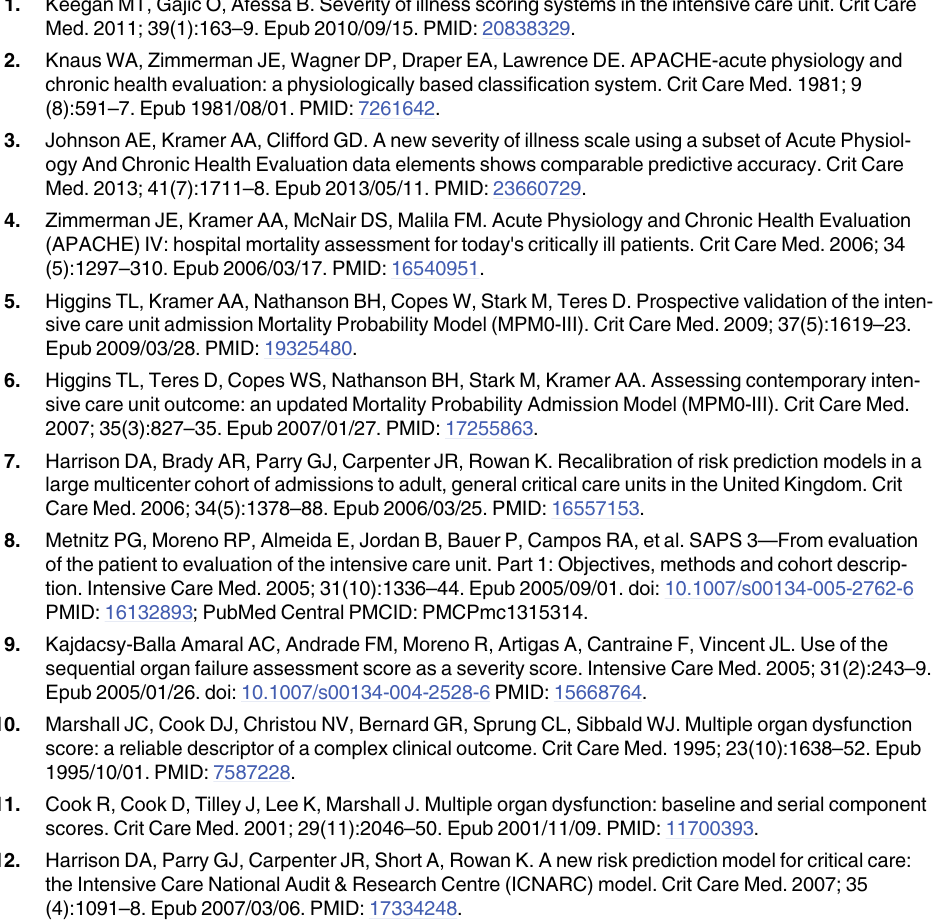
S4 Table. Area under the ROC curve (C-statistic) for R-MPM model and for the model with each variable removed in